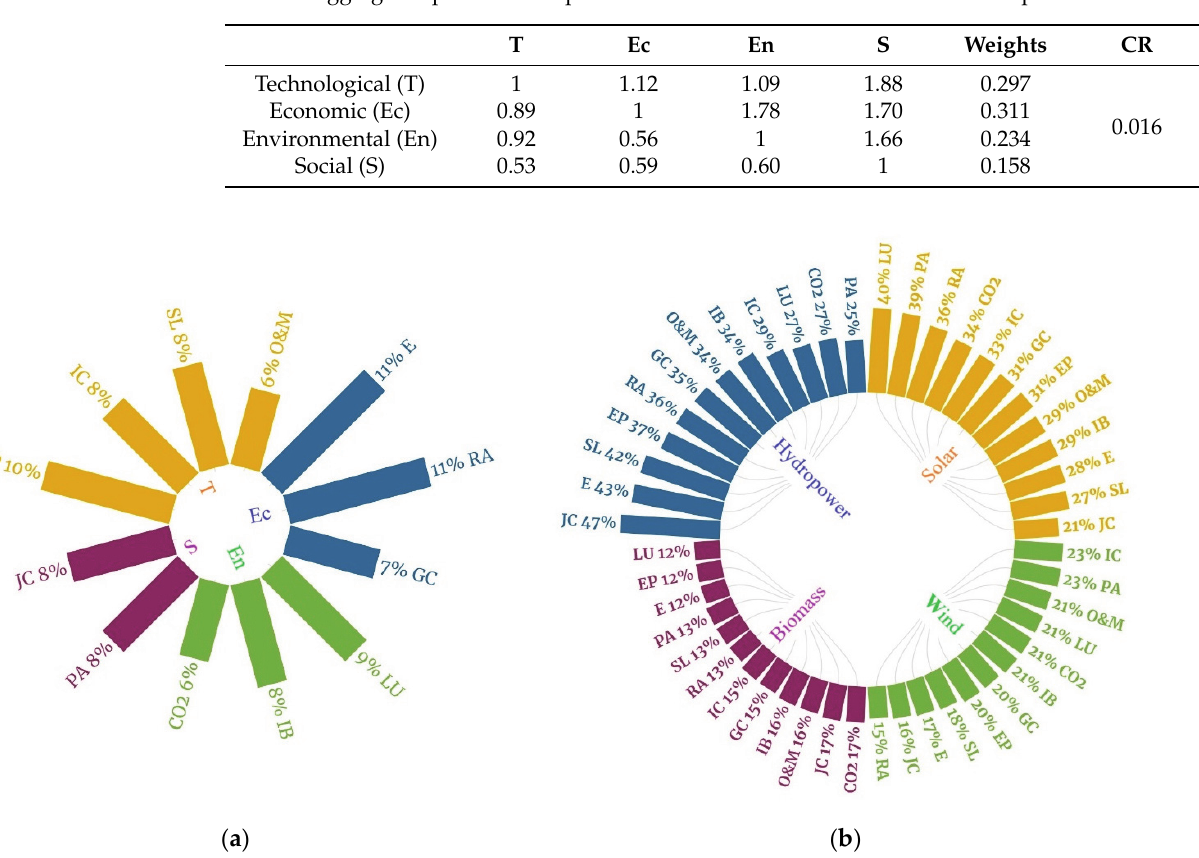
Figure 5. ( a ) Global weights of the sub-criteria; ( b ) RE alternatives priorities with respect to the sub-criteria.